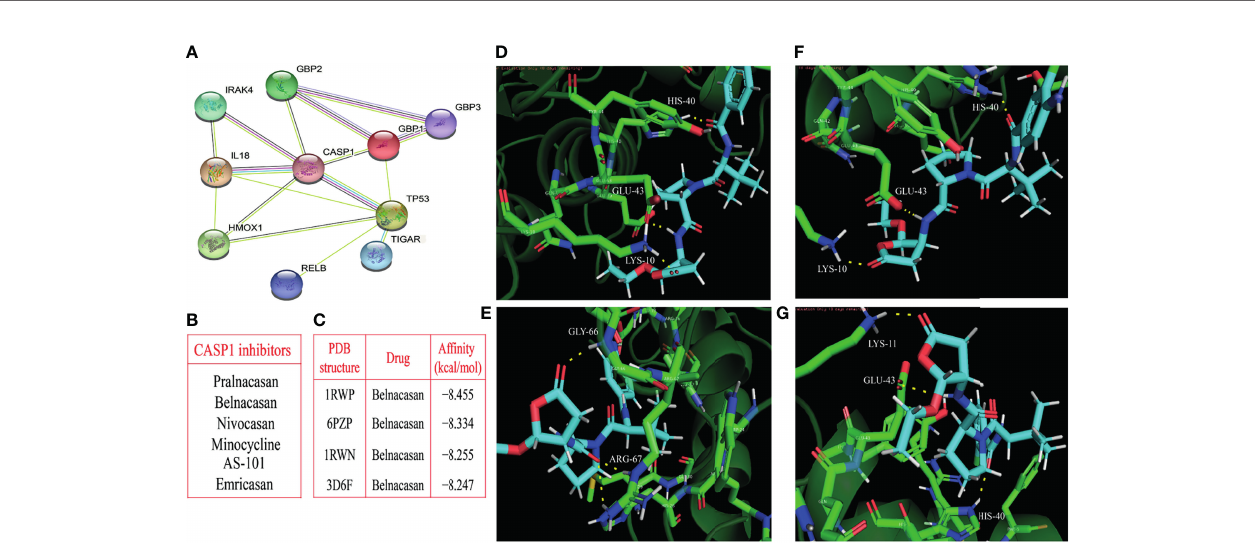
FIGURE 8 | Identi fi cation of the core gene and simulated molecular docking. (A) Construction of the CASP1-centered protein-protein interaction network. (B) Six inhibitors targeting CASP1. (C) Four docking with the strongest af fi nities. The molecular docking of belnacasan ligand and four PDB structures of CASP1 including 1RWN, 1RWP, 3D6F and 6PZP, the amino acid residue generating hydrogen bonds with belnacasan are HIS-40, GLU-43 and LYS-10 for 1RWN (D) , GLY-66 and ARG-67 for 1RWP (E) , HIS-40, GLU-43 and LYS-10 for 3D6F (F) , LYS-11, GLU-43 and HIS-40 for 6PZP (G) . The molecule in blue is belnacasan, the bright green is the amino acid residue of CASP1 docking with belnacasan, and the yellow dotted lines represent the hydrogen bond.